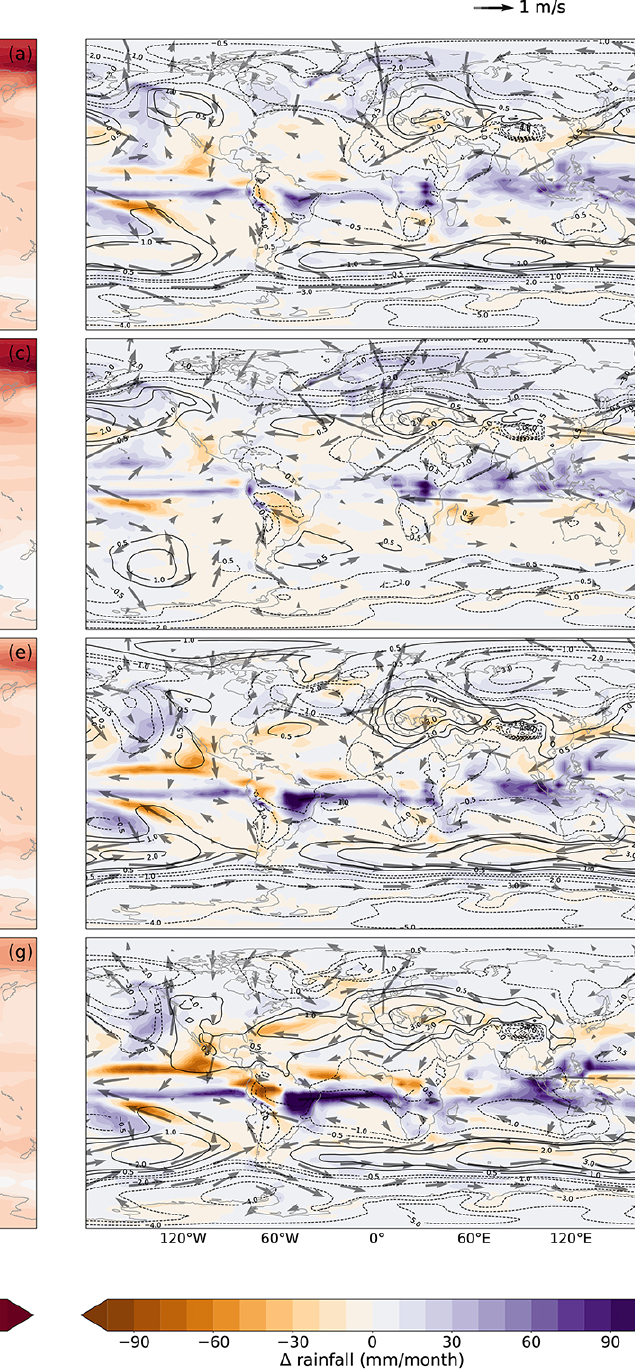
Earth Syst. Dynam., 13, 1259–1287, 2022